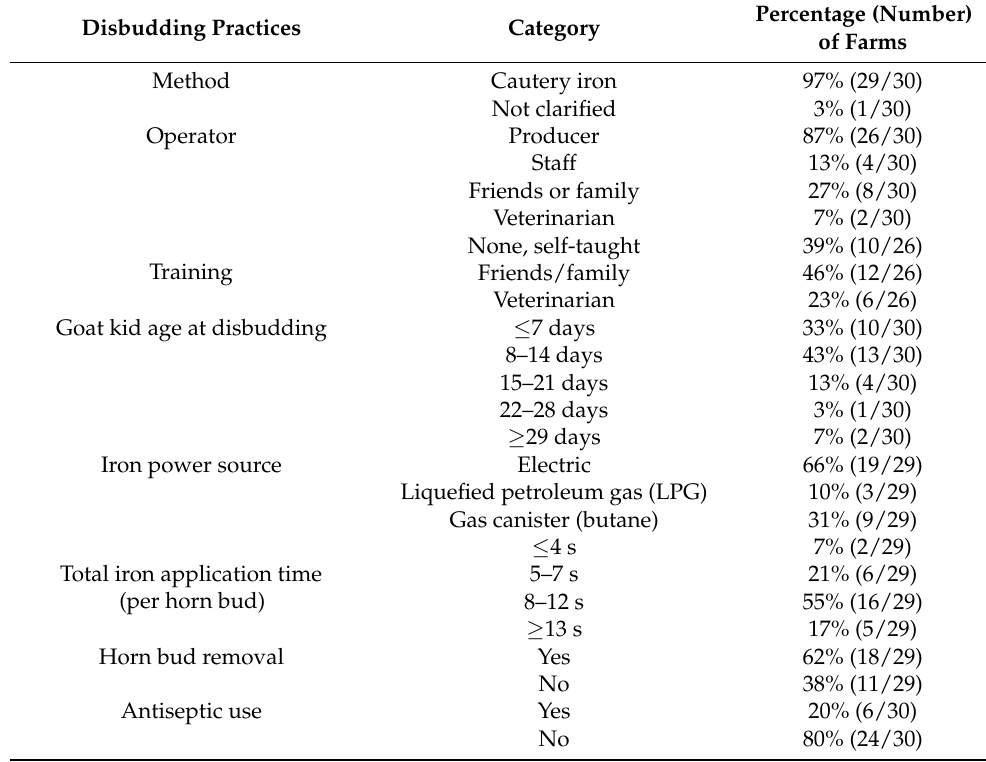
Table 7. Dairy goat producer responses relating to disbudding practices.